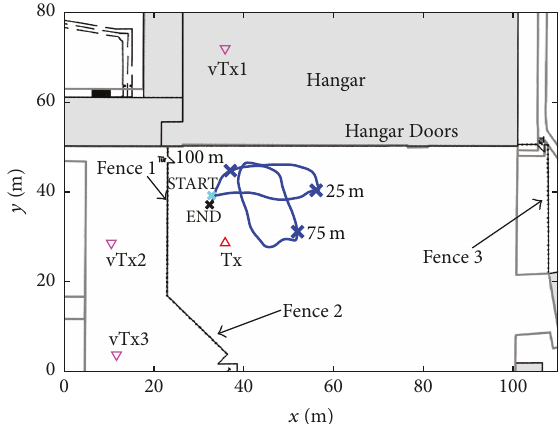
Figure9:Topviewofthemeasurementscenarioinfrontofahangar. The physical transmitter location is marked by the red triangle labeled Tx. The user travels along the blue track from START to END. The expected virtual transmitter locations are marked by the magenta downward